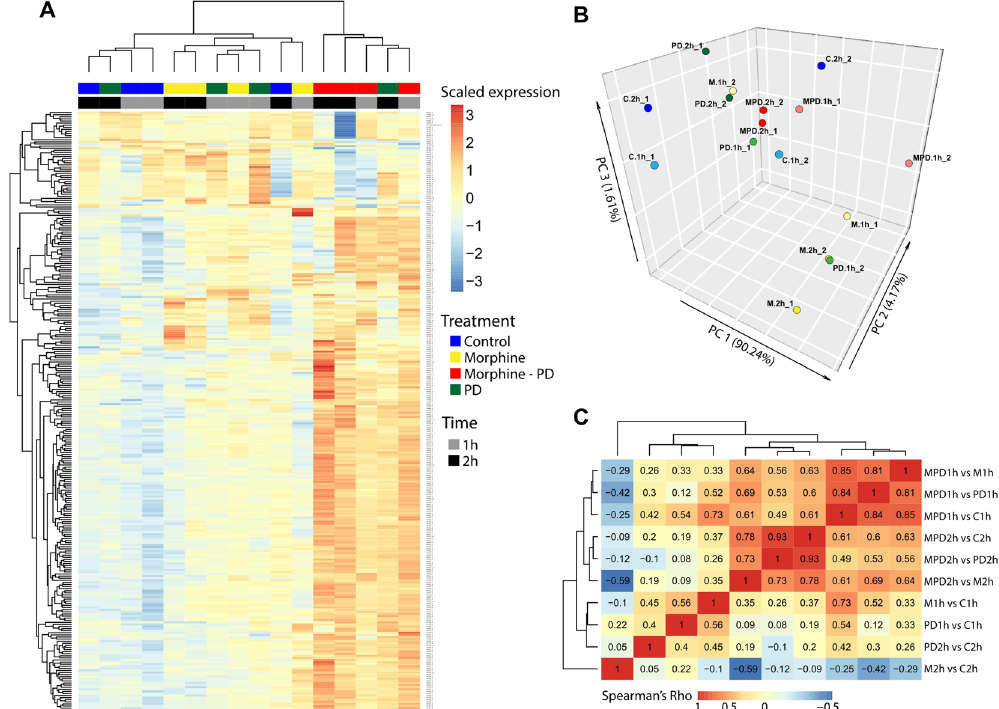
Figure 2. Treatment-induced alterations in gene expression. ( A ) Heatmap of the standardized expression of the 285 differentially expressed genes across the 16 samples. ( B ) Visualization of the 16 samples across the 3 most informative components of a principal component analysis performed on the raw expression values (log2-intensity) of the 285 DEGs. ( C ) Heatmap of the matrix of correlations between the fold-change profiles of the 285 DEGs in the 10 comparisons performed to explore the effect of the treatment regimes on gene